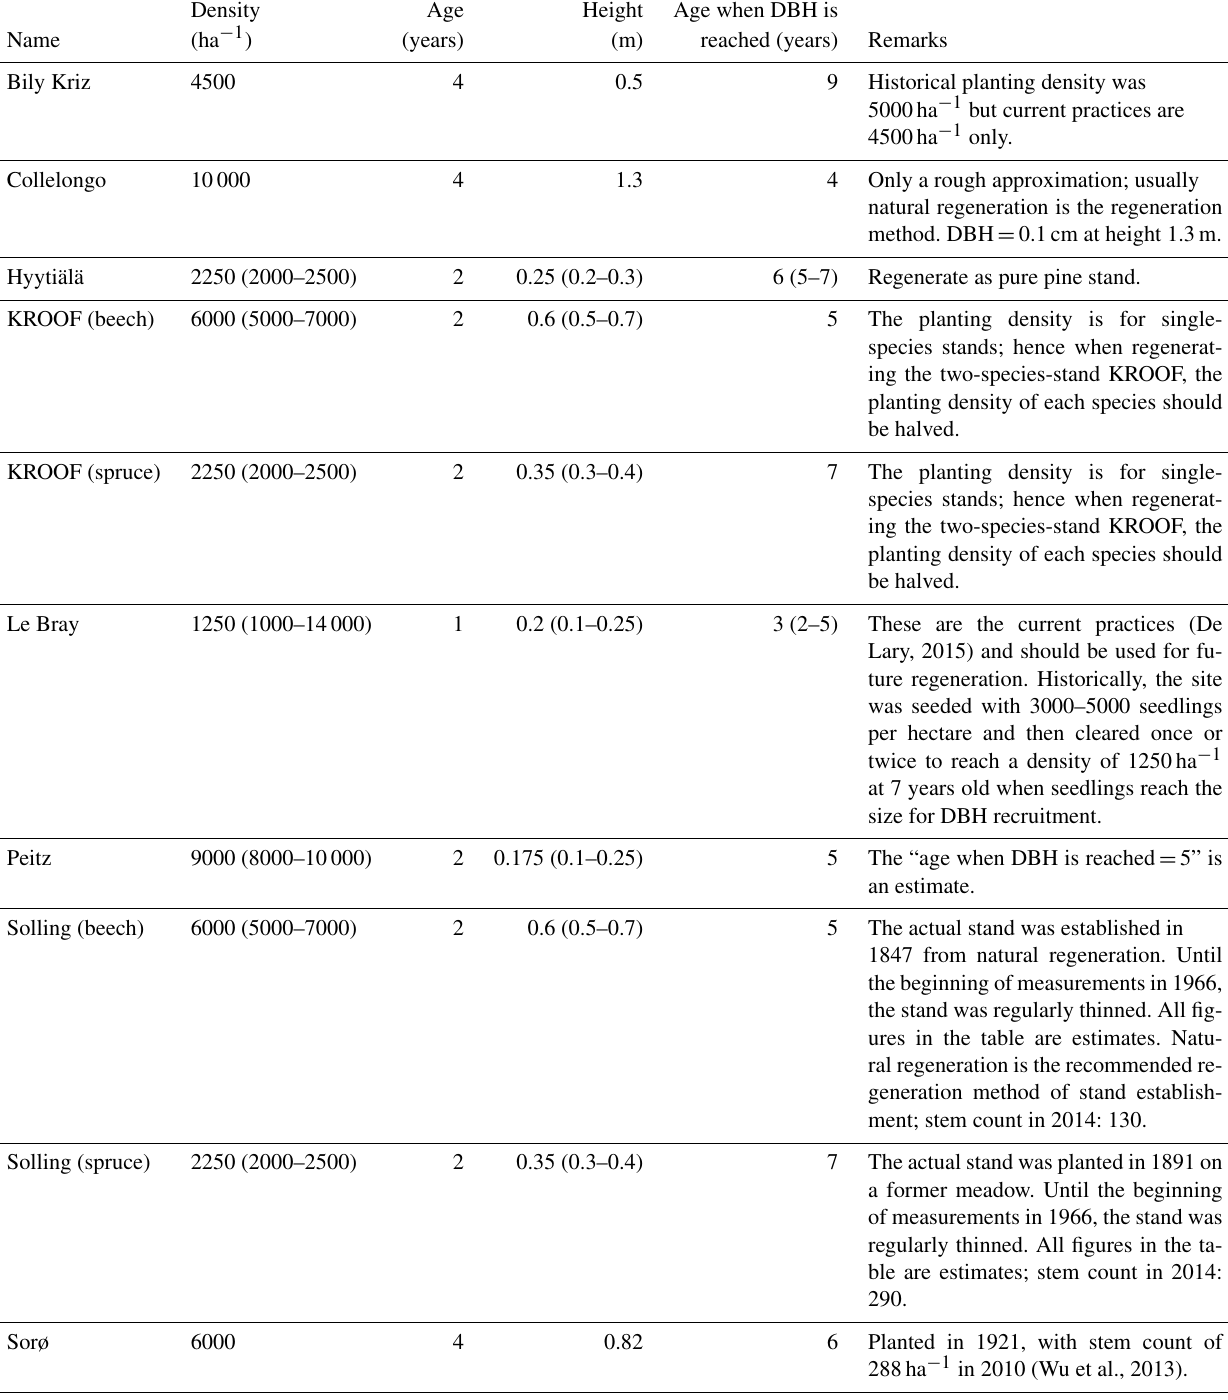
Table 8. Planting information for the sites included in the PROFOUND DB. The numbers in brackets indicate plausible ranges (NA: not